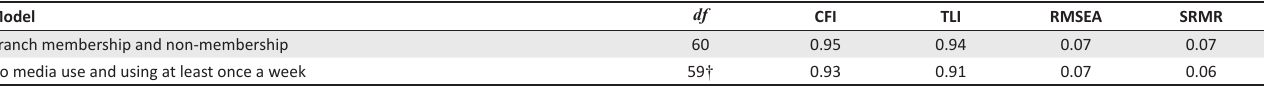
TABLE 3: Results of the measurement models for the multigroup analysis.